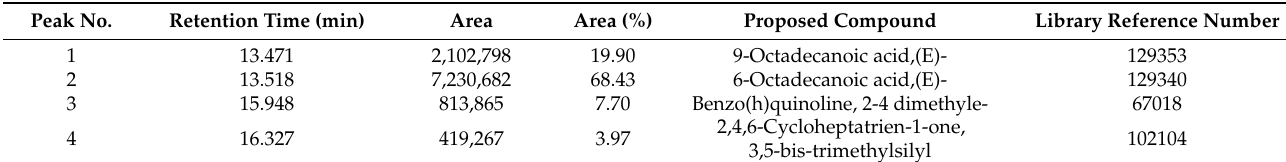
Table 5. GC-MS analysis of spittlebug P. costalis foam.